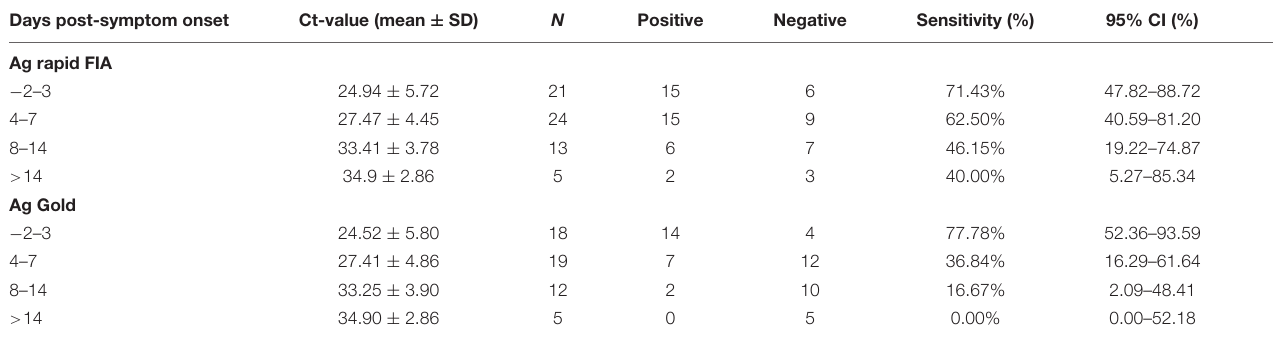
TABLE 4 | Sensitivity of Ag rapid FIA and Ag Gold determined by days post-symptom onset. Days post-symptom